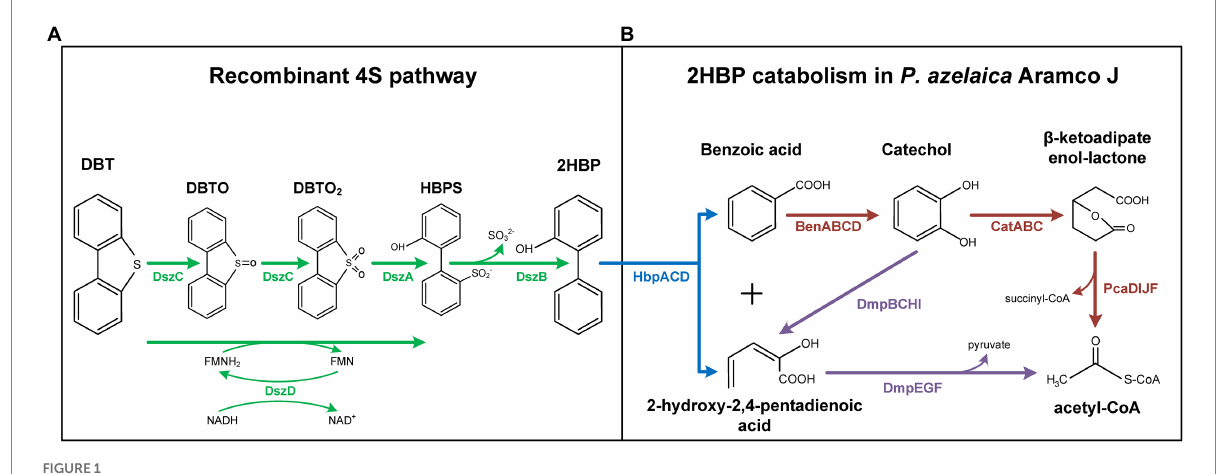
FIGURE 1 Synthetic DBT degradation pathway in recombinant Pseudomonas azelaica AJdsz strain. The synthetic pathway was constructed by coupling a recombinant 4S pathway (A) with a 2HBP degradation pathway naturally present in P. azelaica Aramco J (B) . Green: dsz pathway; blue: hbp pathway; brown: ben-cat-pca pathways; purple: dmp pathway. DBT, dibenzothiophene; DBTO, dibenzothiophene sulfoxide; DBTO 2 dibenzothiophene sulfone; HBPS, 2-hydroxybiphenyl-2-sulfinate; 2HBP,